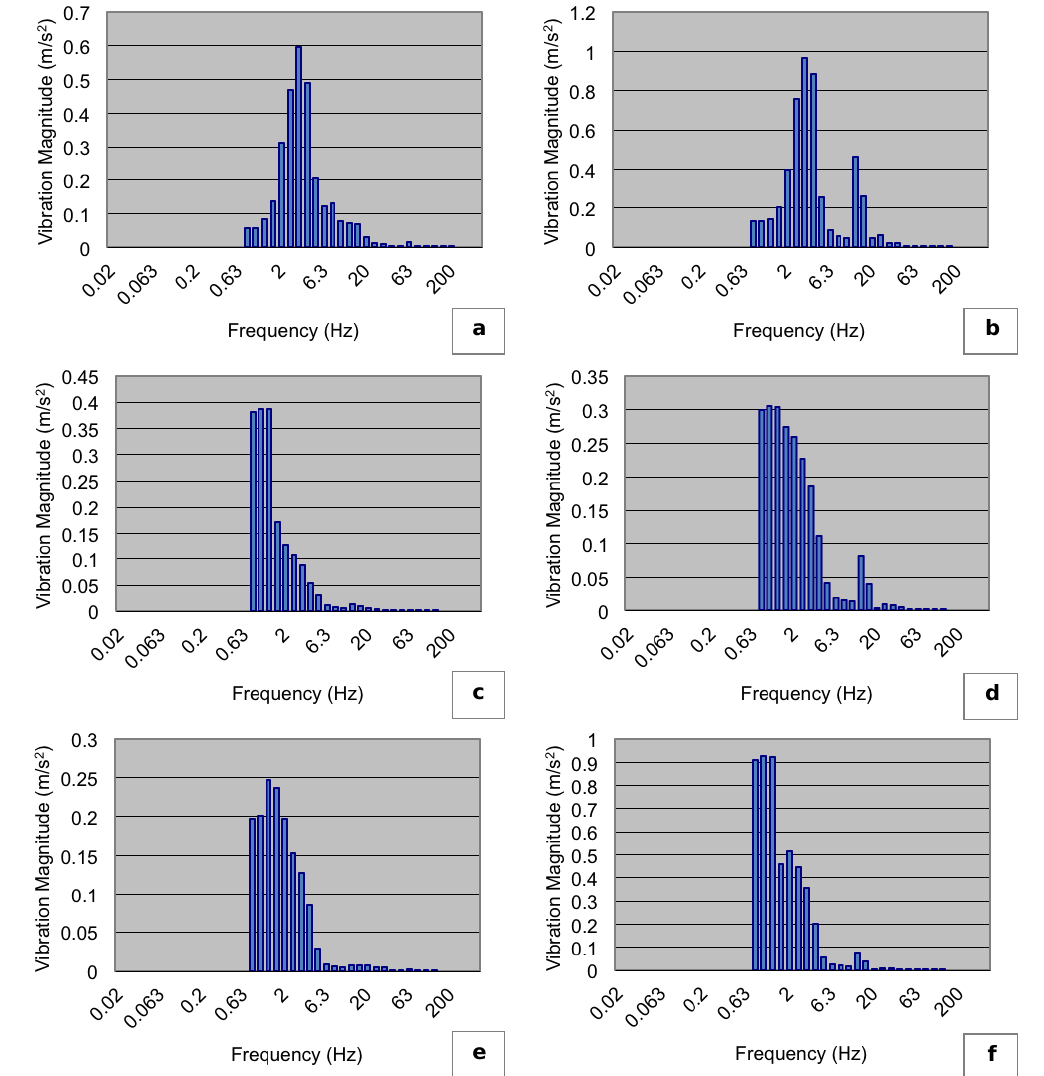
Figure 1. Example 1/3 octave frequency spectrum plots for a large LHD ( a ) z-axis, ( c ) y-axis, ( e ) x-axis; and a small LHD ( b ) z-axis, ( d ) y-axis and ( f ) x-axis.